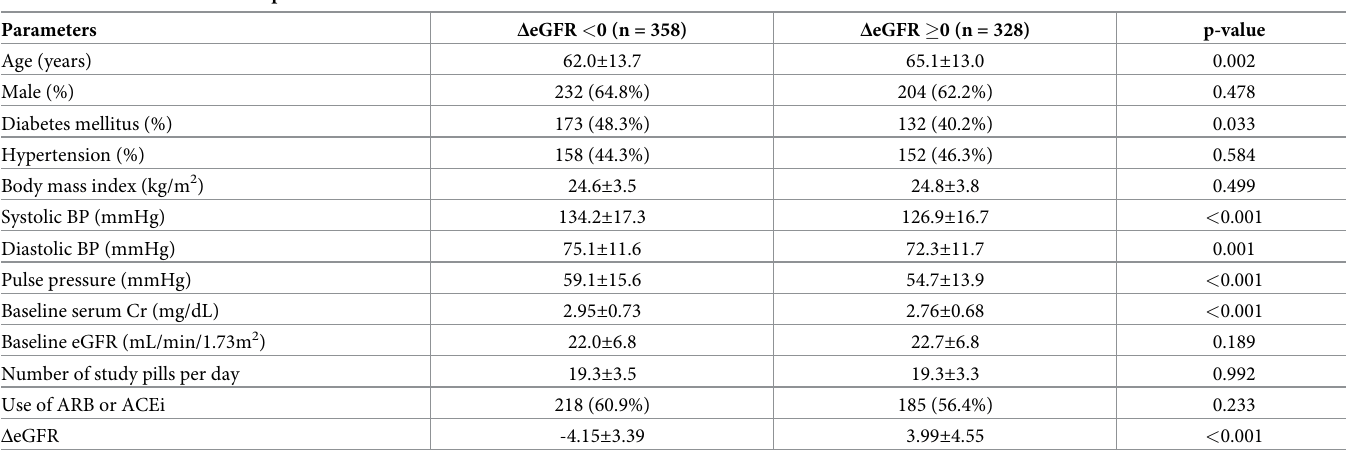
Table 2. Factors associated with preservation of renal